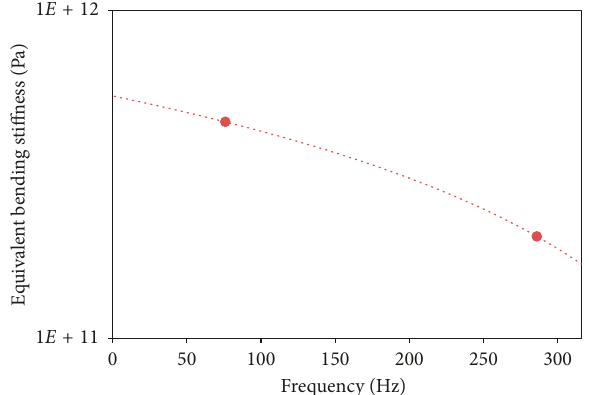
Figure 5: Equivalent bending stiffness obtained for simplified FE model.